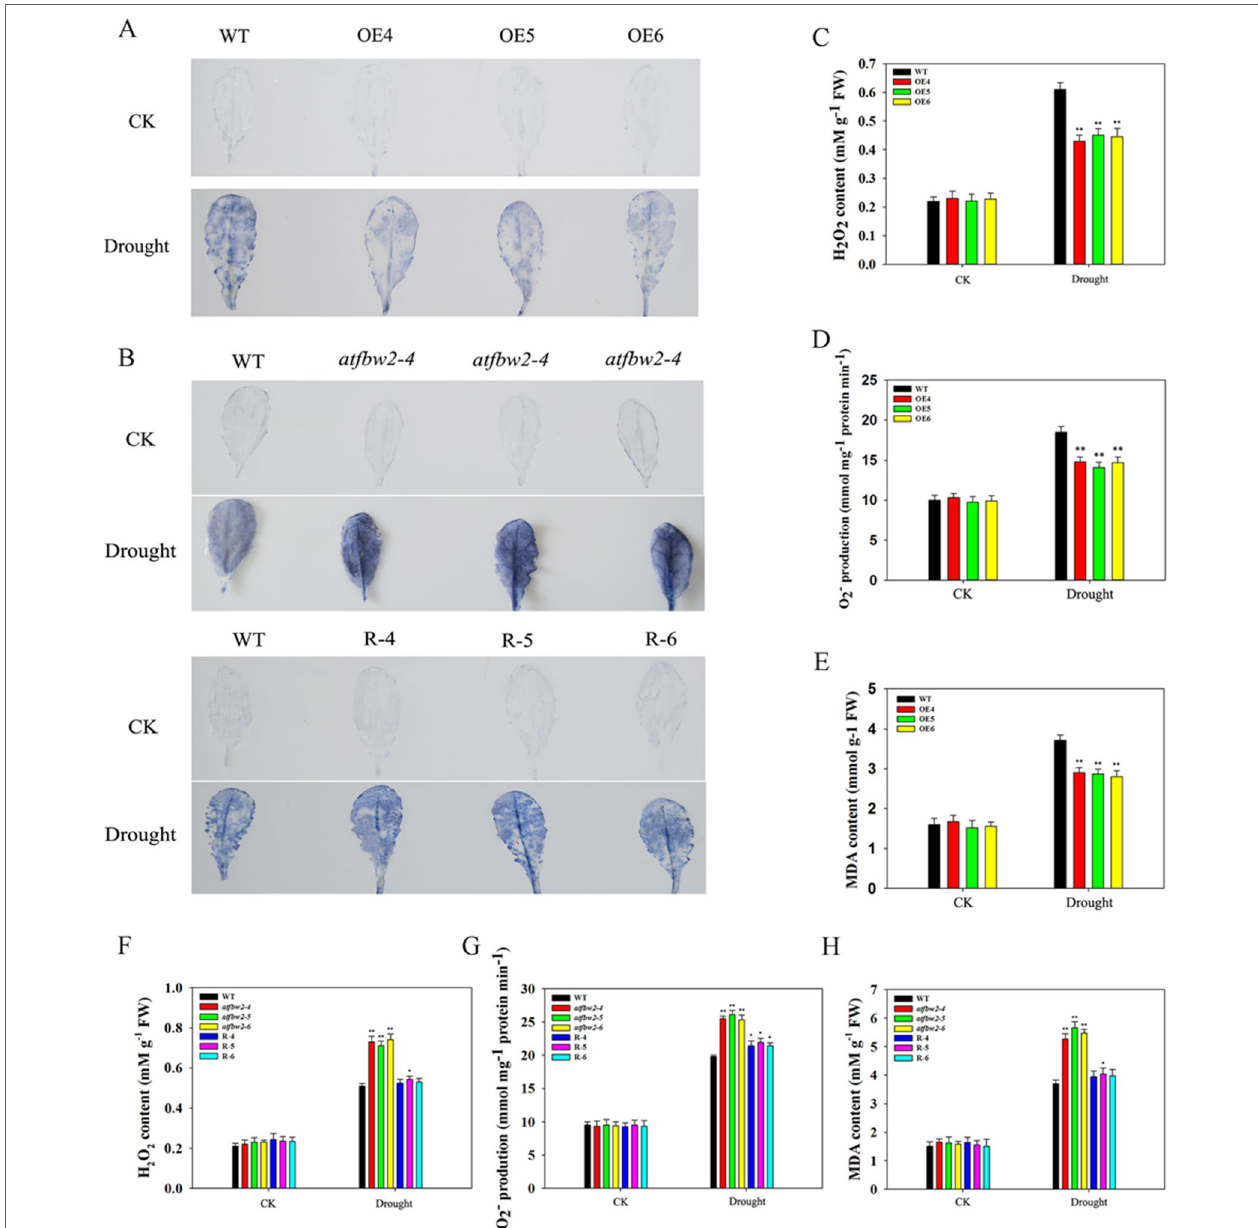
FIGURE 11 | ROS accumulations and MDA content in Arabidopsis plants under drought stress. O 2− accumulations were detected by histochemical staining using NBT in leaves of (A) WT and OEs (OE4, OE5, OE6), as well as (B) WT, mutant ( atfbw2-4 , atfbw2-5, atfbw2-6 ) and recovery (R-4, R-5, R-6) Arabidopsis plants undergoing drought stress. Quantitative analysis of O 2− (D , G ) and H 2 O 2 (C , F) . MDA contents in WT and TaFBA1-overexpressing lines (OE4, OE5, OE6) (E) , as well as (H) WT, mutant ( atfbw2-4 , atfbw2-5 , atfbw2-6 ), recovery plants (R-4, R-5, R-6) under drought stress. Data represent the mean ± SE of three biological replicates. * P < 0.05; ** P <